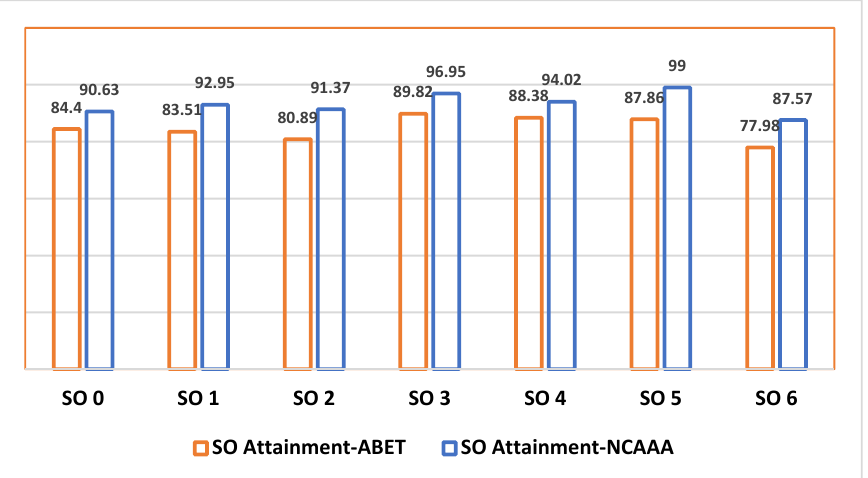
Figure 2. ABET and NCAAA SO Attainment Results.